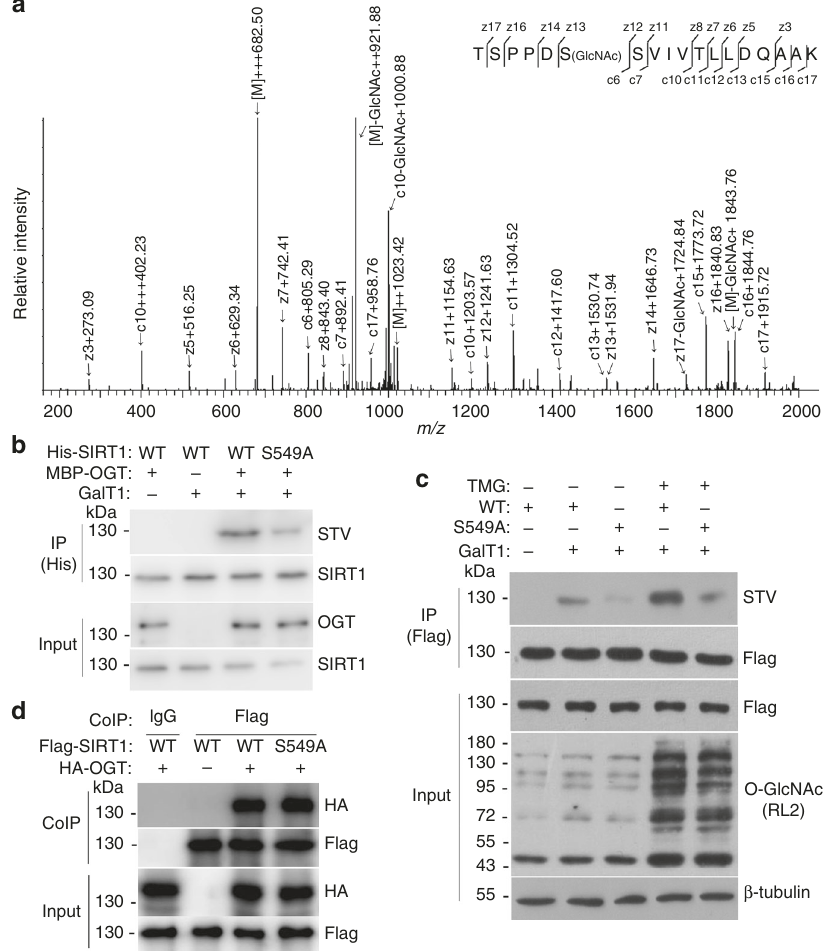
Fig. 3 SIRT1 is O-GlcNAcylated at Ser549. a ETD-MS detected the O-GlcNAcylated peptide of SIRT1 (544 – 561). b Either His-tagged wtSIRT1 or SIRT1 S549A was coexpressed with or without MBP tagged OGT in E. coli . SIRT1 was immunoprecipitated with anti-His antibody, and then O-GlcNAcylation of SIRT1 was detected by chemoenzymatic labeling and IB with STV-HRP. Data represent three independent experiments. c Flag-tagged wtSIRT1 or SIRT1 S549A vector was transfected into NCI-H1299 cells. The cells were lysed after treatment with 2 μ M TMG for 4 h, followed by chemoenzymatic labeling and IB. Data represent two independent experiments. d HA-tagged OGT and Flag-tagged wtSIRT1 or SIRT1 S549A were co-transfected into NCI-H1299 cells, and the CoIP assays were carried out by anti-Flag antibody, followed by IB with anti-HA and anti-Flag antibodies. Data represent two independent